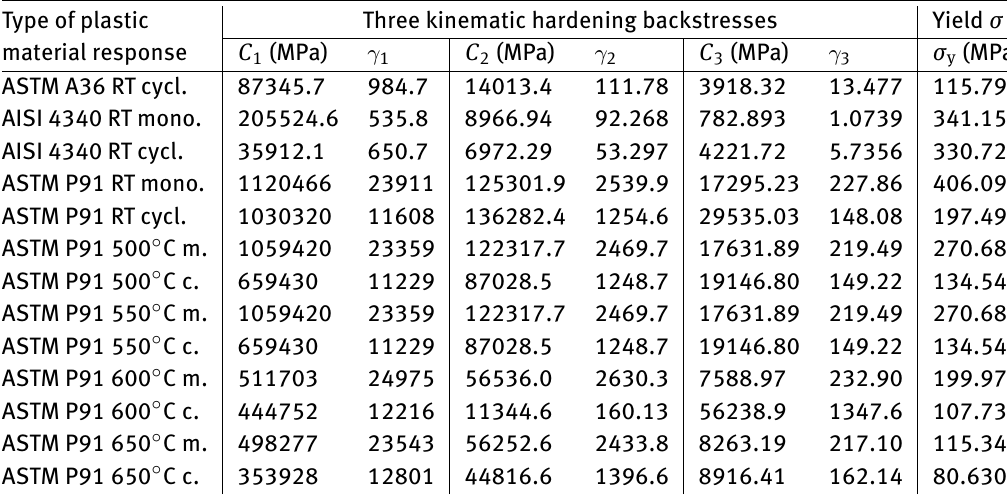
Table 2: Fitting parameters of the Chaboche model (3)-(5) for different steels and temperatures Type of plastic Three kinematic hardening backstresses Yield σ material response ASTM A36 RT cycl.